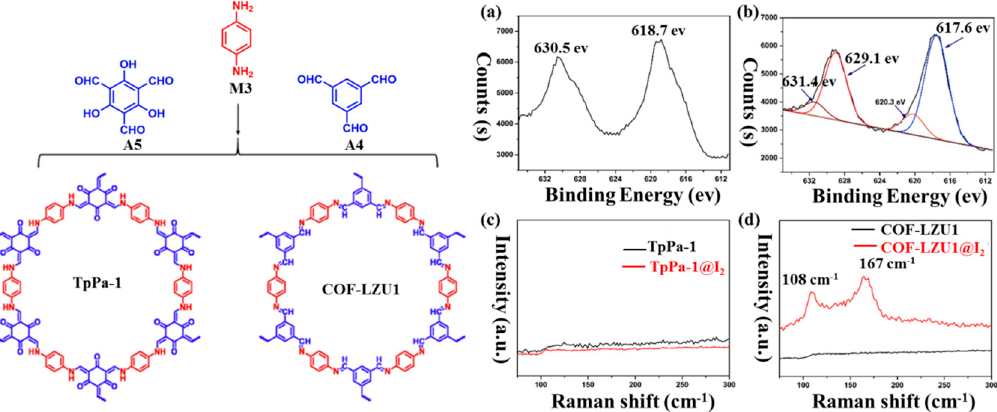
Figure 3. Left: schematic description of the synthesis of TpPa-1 and COF-LZU1. Right: XPS spectra of I 2 @TpPa-1 ( a ) and I 2 @COF-LZU1 ( b ), and Raman spectra of TpPa-1 ( c ) and COF-LZU1 ( d ) before and after volatile iodine adsorption. Reprinted/adapted with permission from Ref. [57]. Copyright (2019), Elsevier.